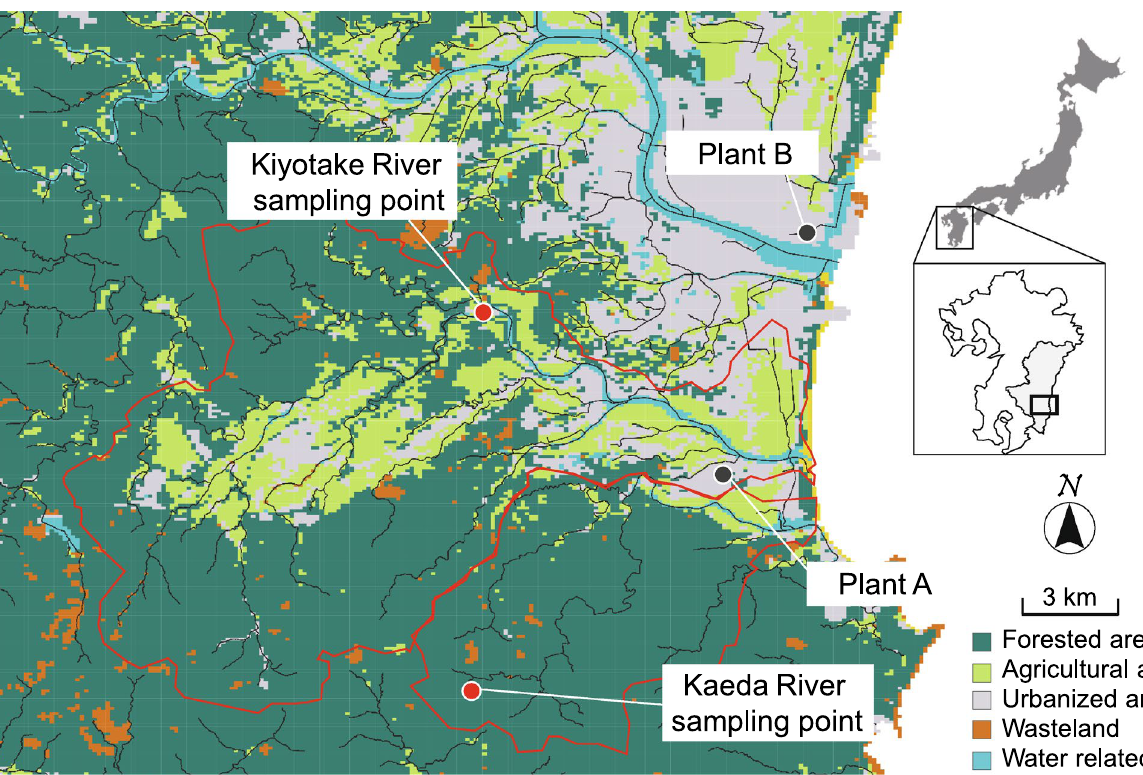
Figure 1. Sampling points of the Kiyotake and Kaeda Rivers in southern Japan, with the distribution of major land use classifications. The map was generated using QGIS ver.2.18.6 (https ://www.qgis.org/) with the Geographic Information System (GIS) data including Land-use distribution data (https ://nlftp .mlit.go.jp/ksj/ gml/datal ist/KsjTm plt-L03-b.html), River network data (https ://nlftp .mlit.go.jp/ksj/gml/datal ist/KsjTm plt-W05. html) and Watershed data (https ://nlftp .mlit.go.jp/ksj/gml/datal ist/KsjTm